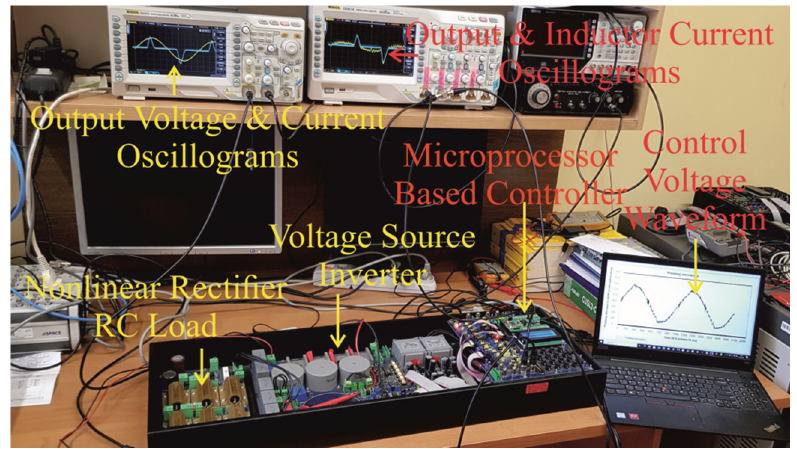
Figure 7. Experimental laboratory inverter.